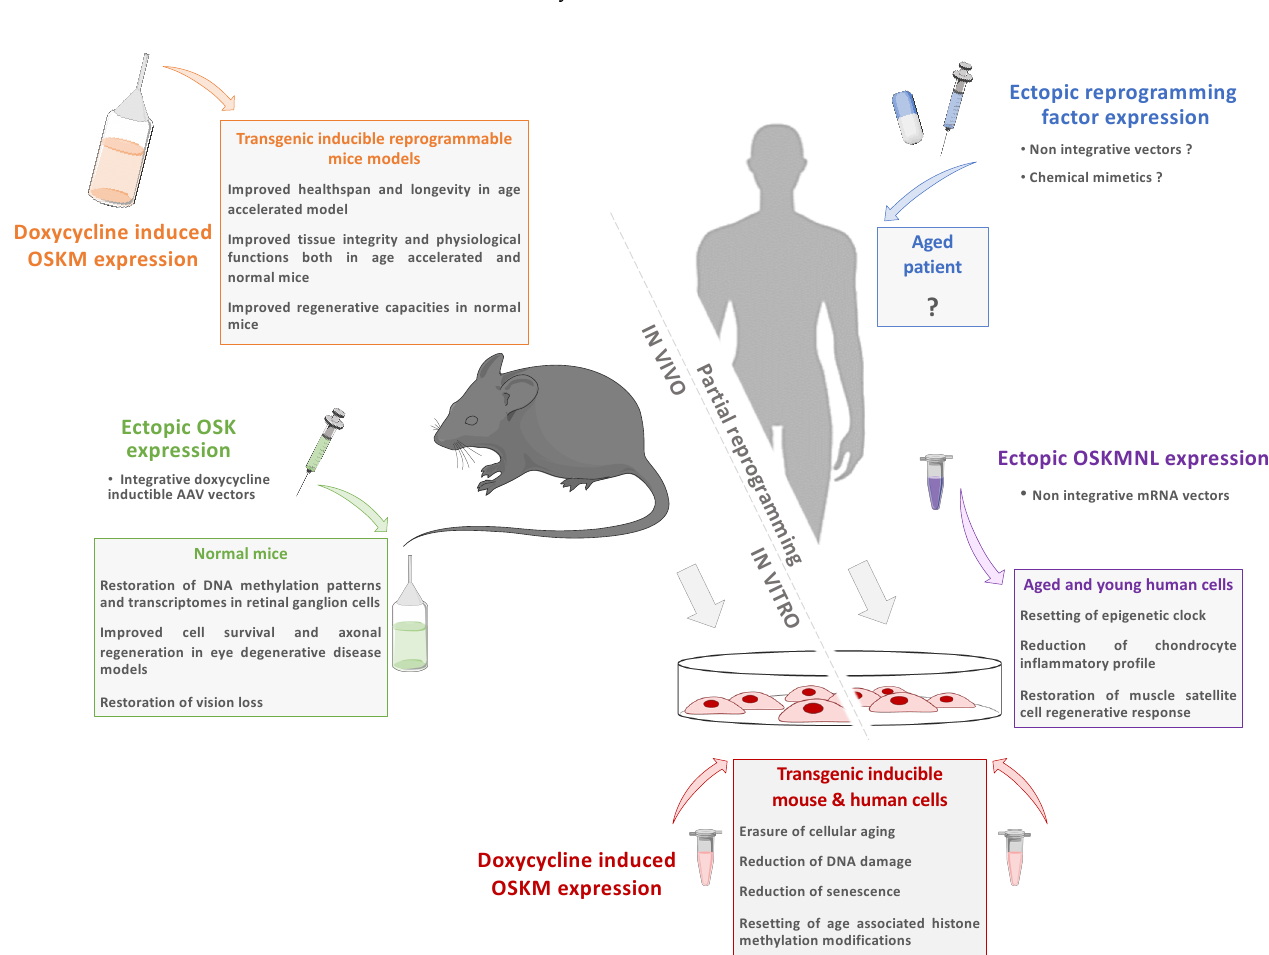
Figure 3. Partial reprogramming toward pluripotency as a new anti-aging strategy. For decades, complete cell reprogram- ming has been demonstrated to reset somatic cell physiology to a juvenile state equivalent to ESCs. Starting from transgenic models allowing inducible reprogramming factor expression to non-integrative vectors; numerous studies have recently demonstrated that a partial reprogramming is sufficient to restore the general characteristics of cellular aging without changing the identity of the cells. These innovative approaches pave the way for new strategies based on a safe transient reprogramming that can be directly transposed to